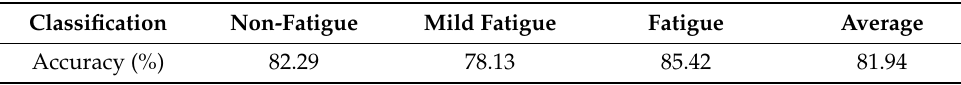
Figure 15. Identification results of the pilots’ fatigue state based on the LVQ model. Table 11. Identification accuracy rate based on the LVQ model.